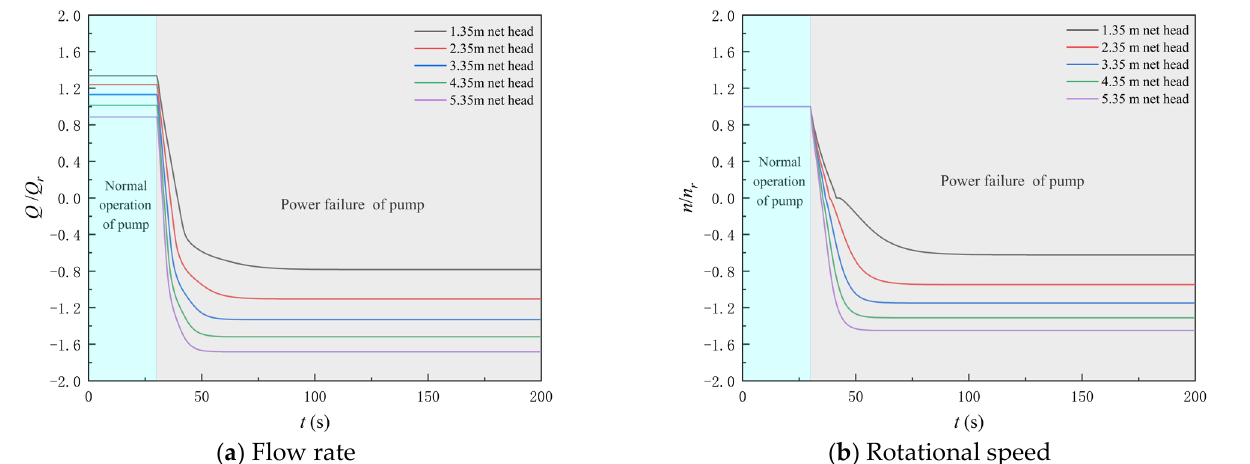
Figure 10. The variation of the flow and speed of the LAPS after the power was turned off in the case of the GOOC.